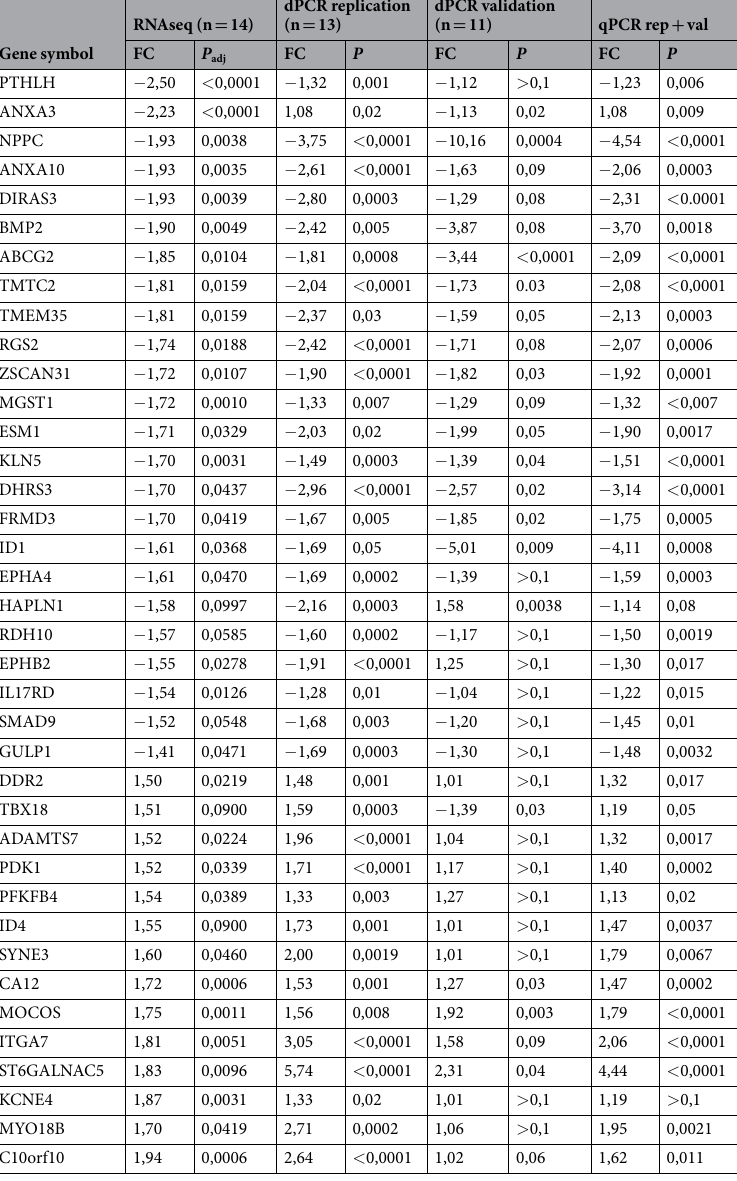
Table 2. Replication of 38 genes in RNAseq samples and validation in independent